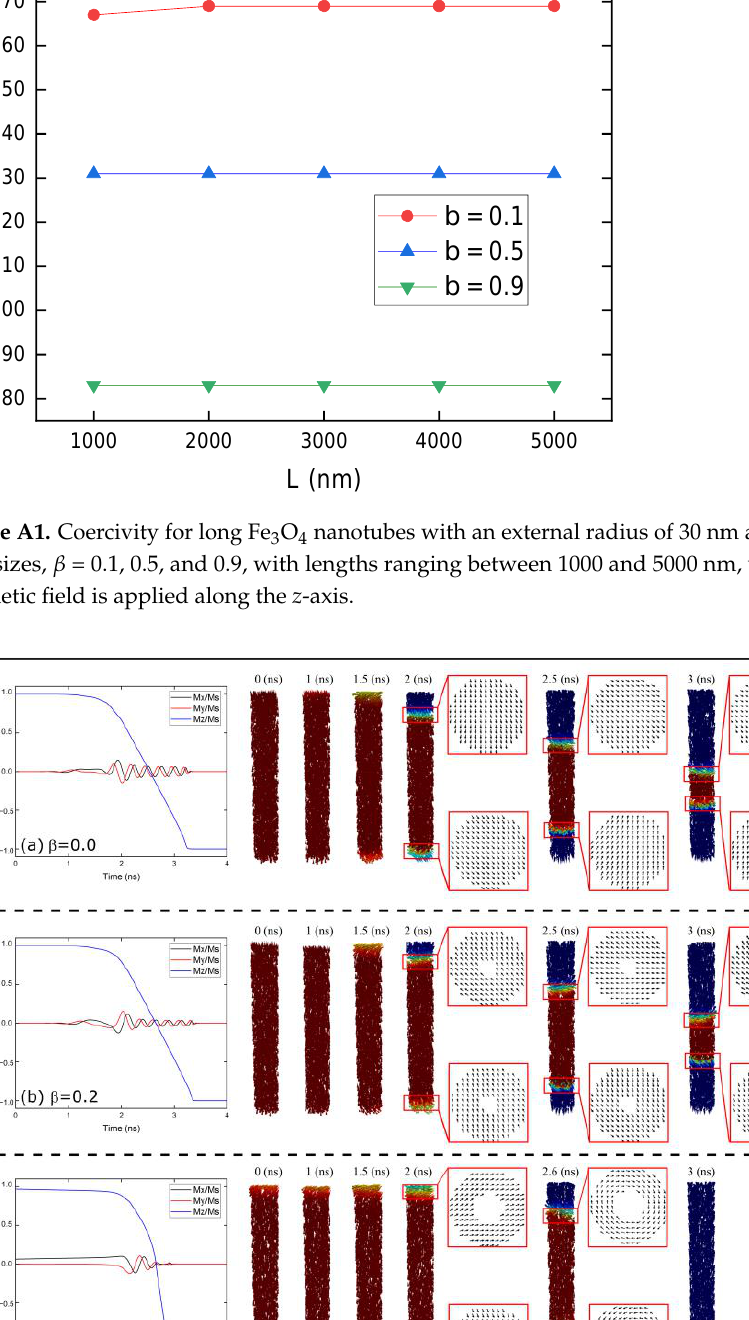
Figure A3. Magnetization reversal of a 1000 nm long Fe 3 O 4 nanotube with an external radius of 80 nm, for  = 0.0 ( a ), 0.1 ( b ), and 0.2 ( c ). The graphs on the left depict the components of magnetization